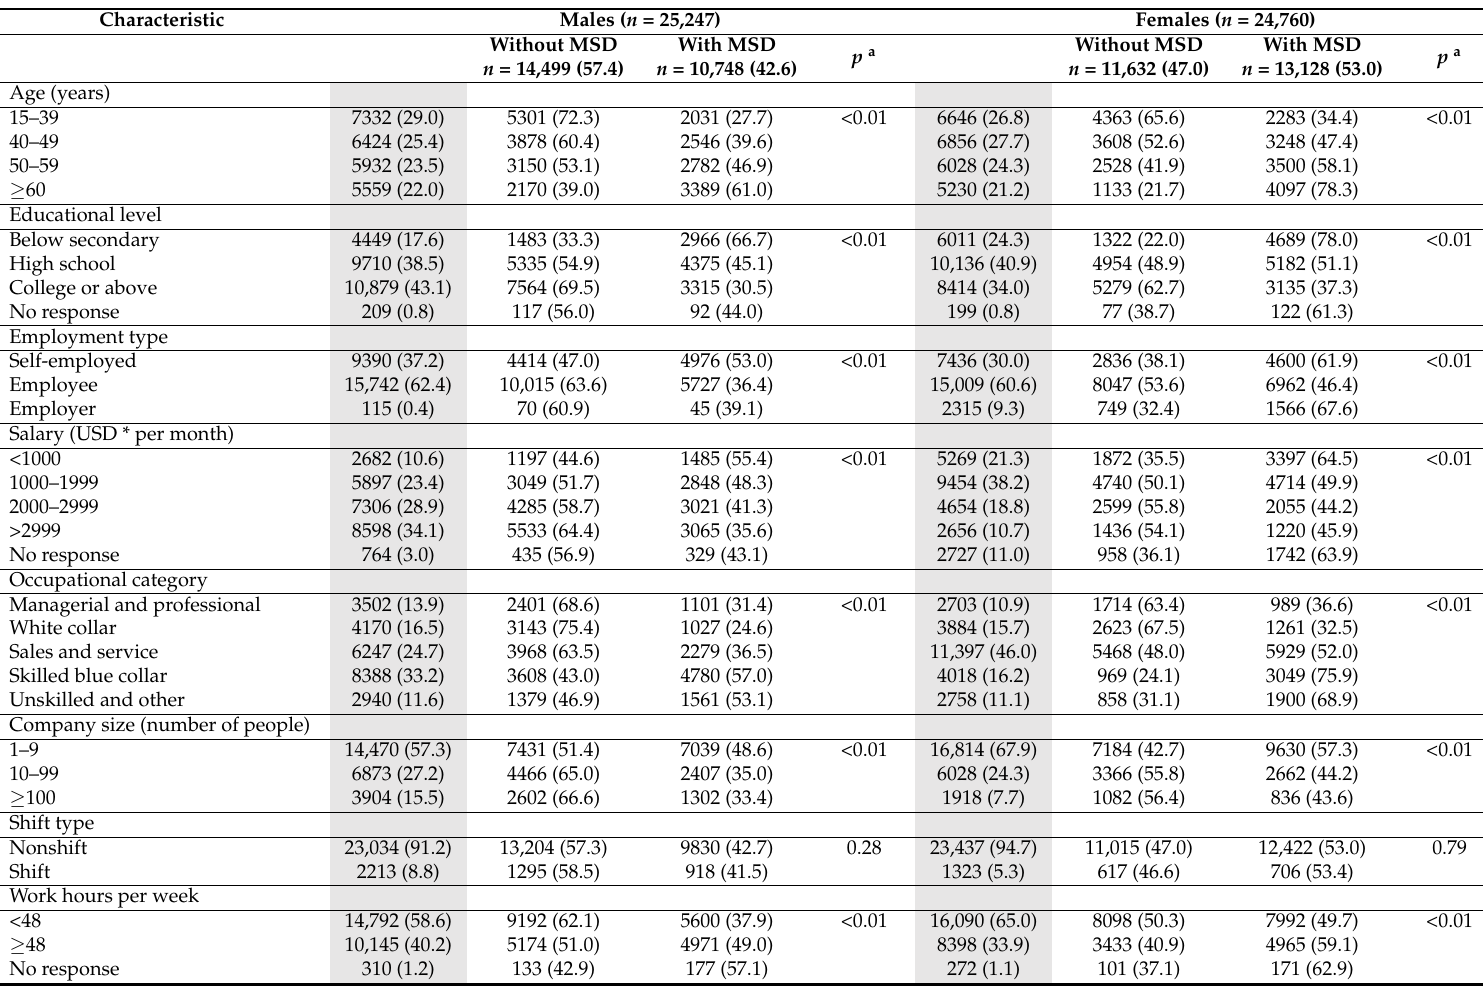
Table 1. Demographic characteristics of the study population and prevalence of MSDs in the past 12 months n (%).